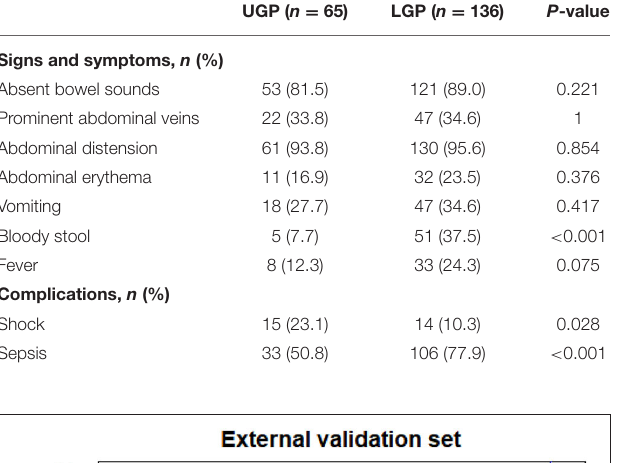
FIGURE 5 | Calibration curves of the nomogram model showing the predicted vs. actual probability for upper GIP (gastrointestinal perforation) in the validation